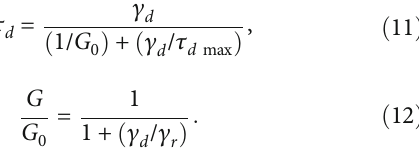
Figure 11: Calcareous sand ð σ